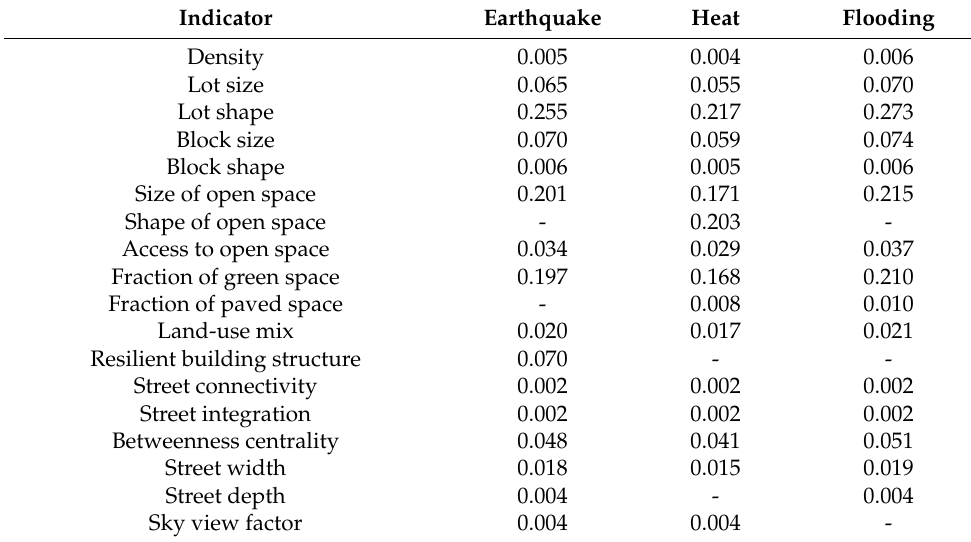
Figure 5. Distribution pattern of the size and shape of blocks. Table 4. The indicator weights calculated using Shannon entropy.